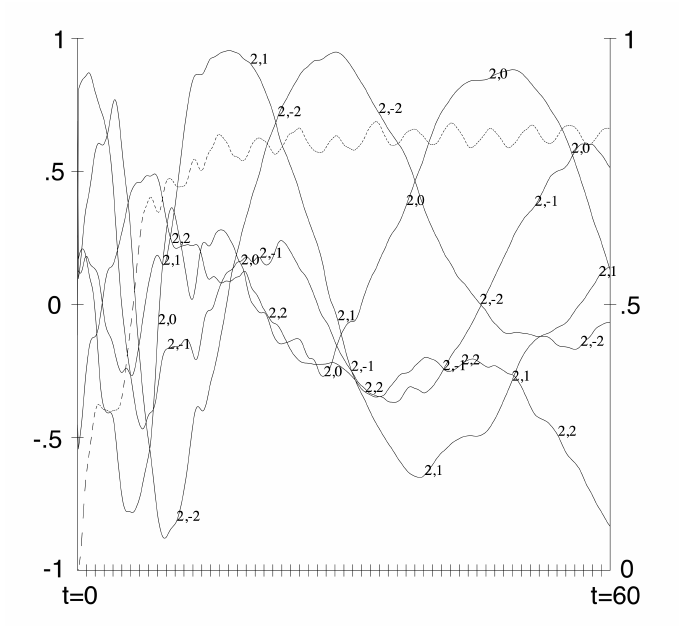
Figure 6. Evolution of a non-rotating, inviscid flow, in which the initial energy is confined to spherical harmonic degrees n = 4,5,6. The dashed curve (right scale) is the fraction of energy in n = 2, which vanishes initially, but, according to theory, will eventually reach 0.996. The other curves, labeled 2, m , represent the normalized coefficient of Y m in the spherical harmonic representation of the flow, which 2 vary between ± 1 (left